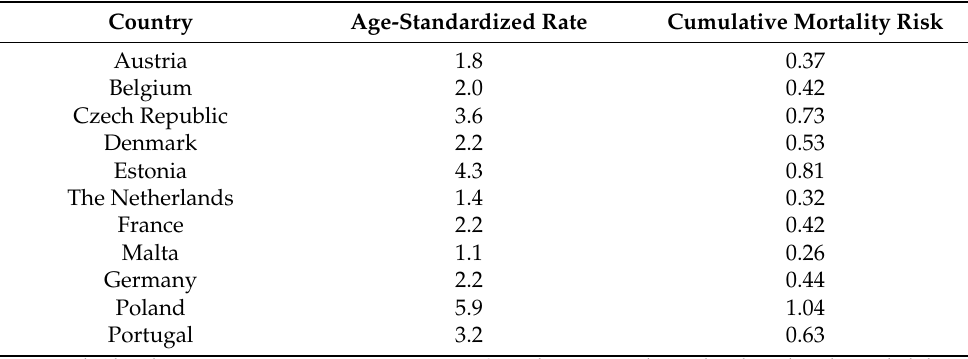
Table 3. Cervical cancer—mortality rates in selected European